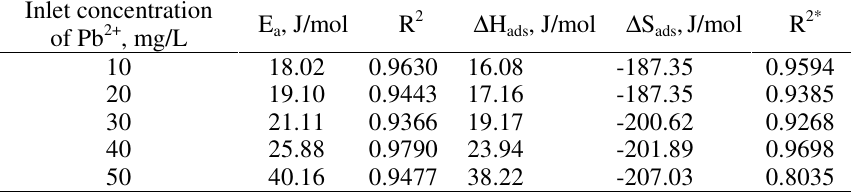
Figure 10. The plot of [Pb 2+ ] Table 4. Thermodynamic parameters and activation energy for the adsorption of Pb 2+ onto human hair Inlet